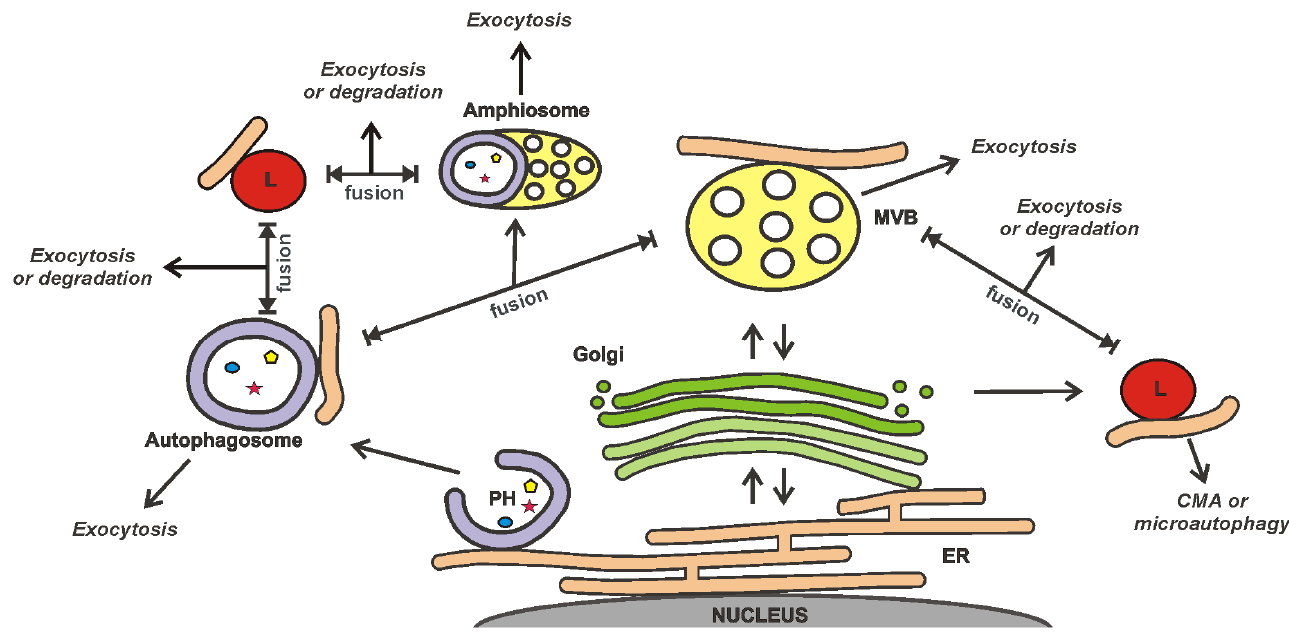
Figure 1. MVB interacts with other secretory and degradation processes in a cell. MVBs, au- tophagosomes, and amphisomes may undergo exocytosis or fusion with lysosomes, resulting in either degradation of their content or lysosomal exocytosis. It should be noted that some paths shown in the figure are hypothetical. The scheme was prepared on the basis of the reviews [82,84,88–90]. MVB—multivesicular body; PH—phagophore; CMA—chaperone-mediated autophagy; ER—endoplasmic reticulum; L—lysosome .